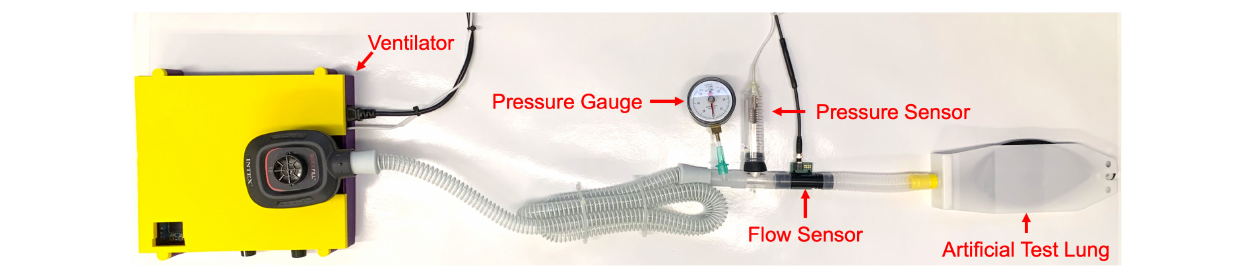
FIGURE 3 | Experimental setup for benchtop